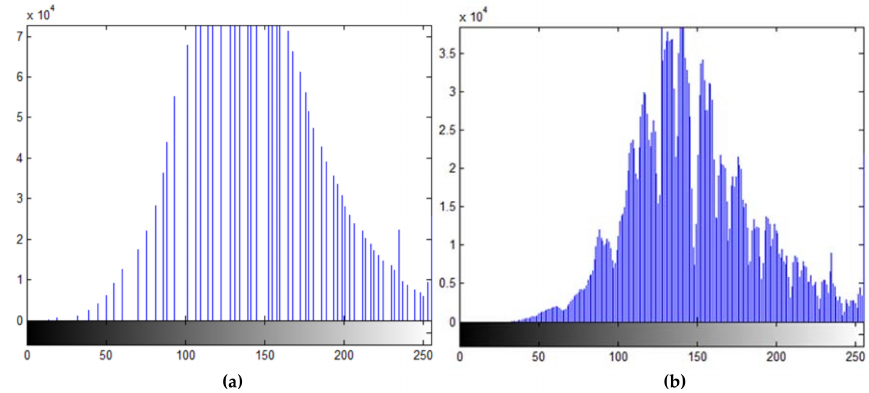
Figure 7. Intensity histograms of a low-intensity shot-peened sample: ( a ) before blurring; ( b ) after blurring.